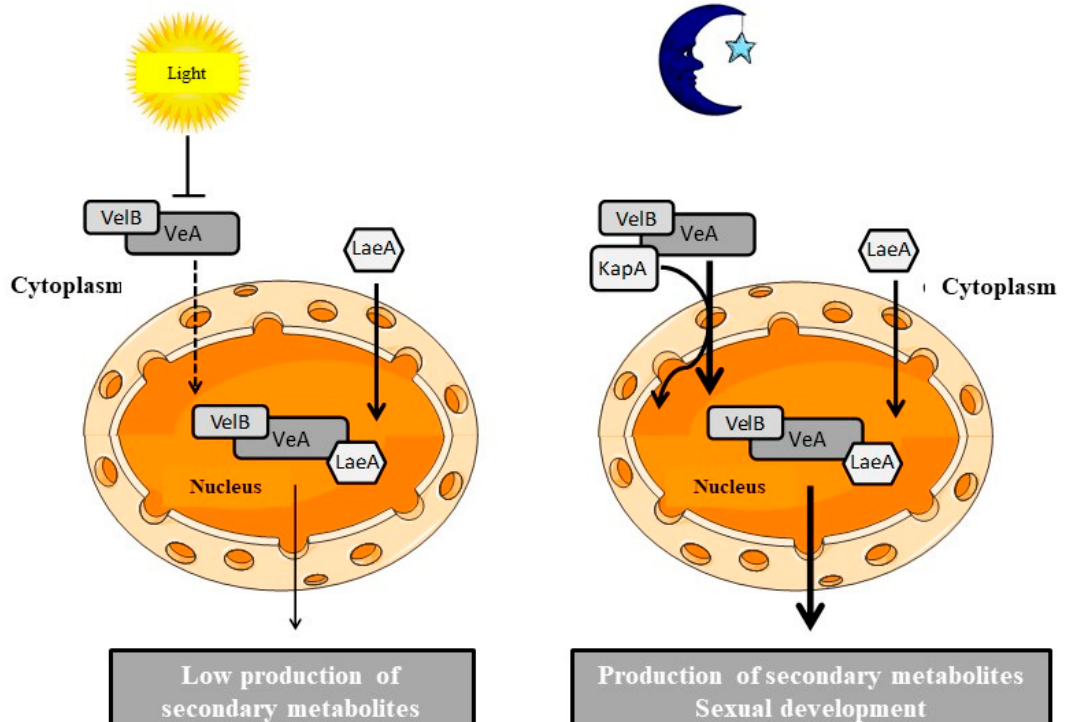
Figure 4. Operating model of the velvet complex in Aspergillus nidulans adapted from Bayram et al. [127]. In the presence of light, VeA is retained in the cytoplasm (—–), and LaeA has low activity. In the dark, VeA coupled to VelB is transported in the nucleus by the importin α KapA (——), and the velvet complex is formed with LaeA to activate the production of secondary metabolites and sexual development.